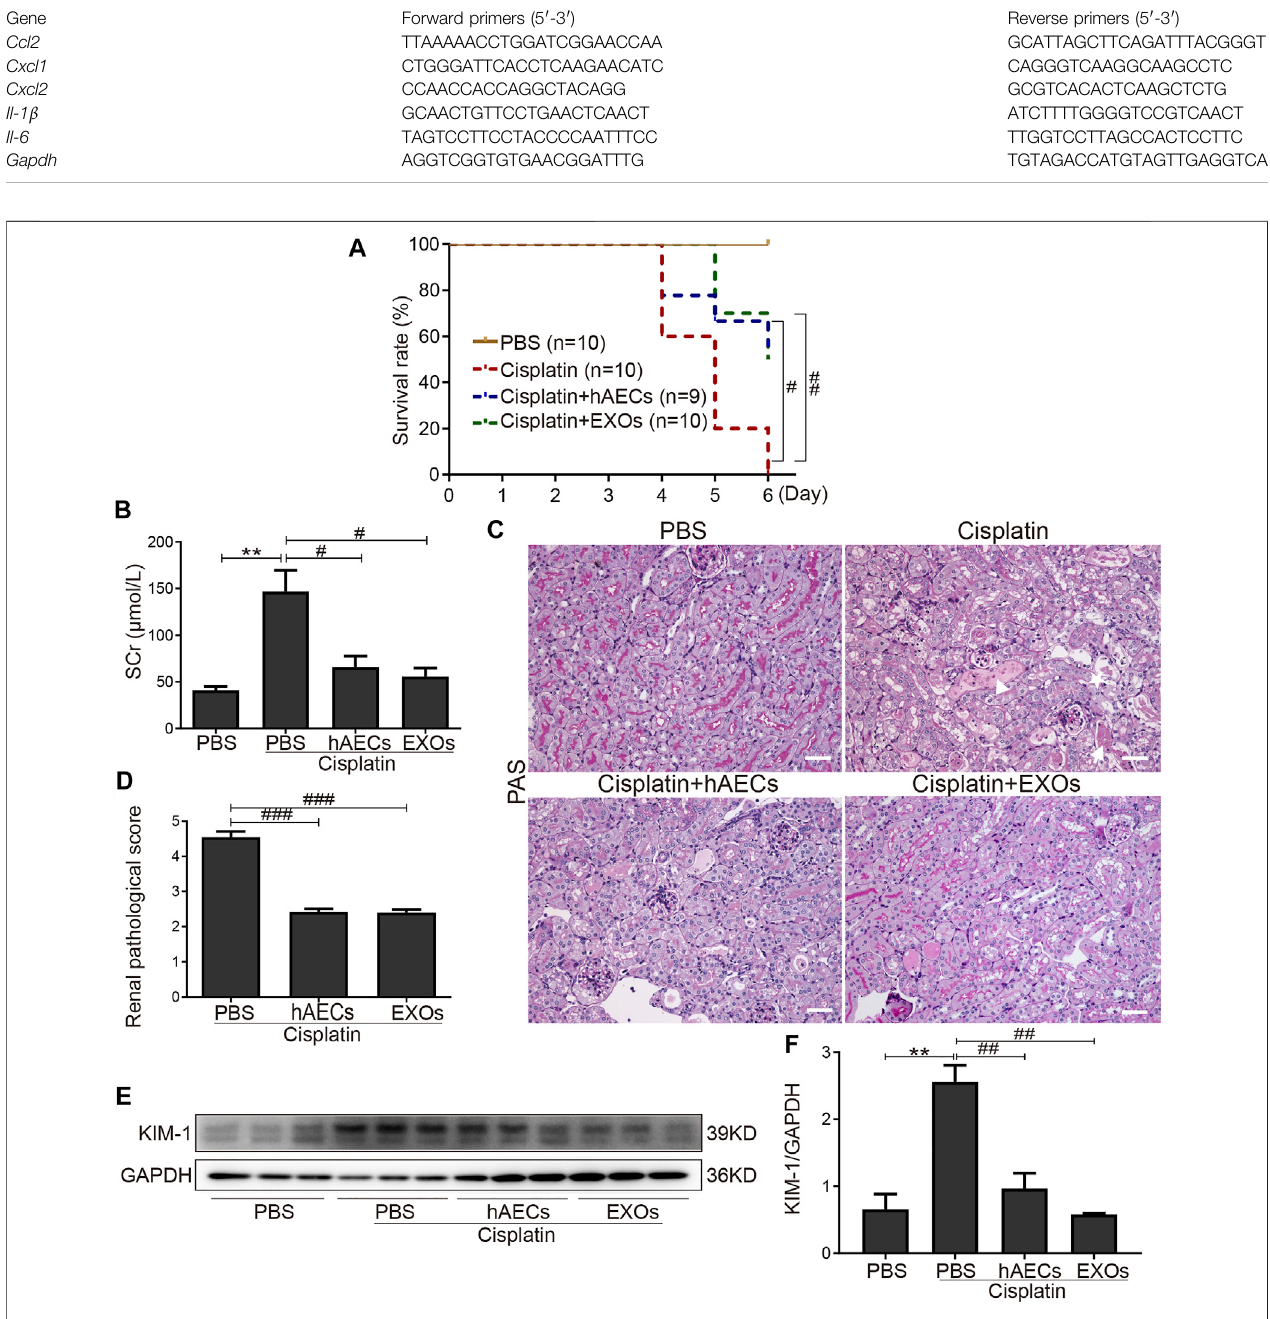
FIGURE1| EffectsofhAECsorEXOsonC57BL/6Jmicewithcisplatin-AKI. (A) The6-daymortalityrateinmicetreatedwith20 mg/kgcisplatin( n (cid:1) 9or10micein eachgroup). (B) sCrlevelsofmicetreatedwith15 mg/kgcisplatin( n (cid:1) 10). (C) RepresentativemicrographsofPASstainingofkidneysfrommicewith15 mg/kgcisplatin treatment. Triangle indicates renal tubular necrosis, pentagram indicates the shedding of the brush edge of renal tubules, and arrow indicates the formation of renal casts. Scalebar,100 μ m. (D ) Semiquantitativerenal pathologicalscoresofmice treatedwith15 mg/kgcisplatin( n (cid:1) 3). (E) RepresentativeWestern blotsshowing protein expression ofKIM-1 inkidneys frommice treated with15 mg/kgcisplatin. (F) Therelative protein expression ofKIM-1 toGAPDH indifferentgroups( n (cid:1) 3). Data are shown as mean ± SEM. ** p < 0.01 vs. PBS group, # p < 0.05, ## p < 0.01, and ### p < 0.001 vs. cisplatin group. hAECs, human amniotic epithelial cells; EXOs, exosomes; cisplatin-AKI, cisplatin induced acute kidney injury; sCr, serum creatinine; PAS, periodic acid-Schiff; KIM-1, anti-kidney injury molecule 1.